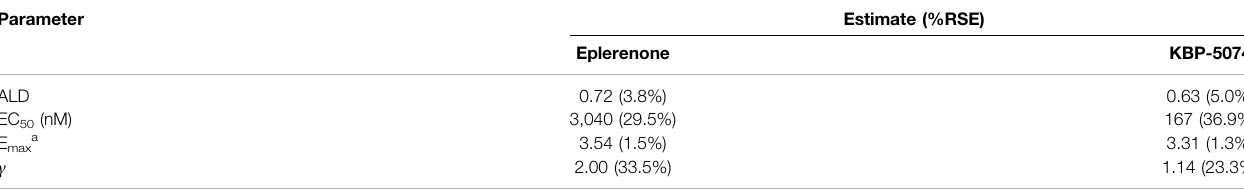
TABLE 5 | PK/PD parameter estimates for urinary Na + /K + ratio for eplerenone and KBP-5074.